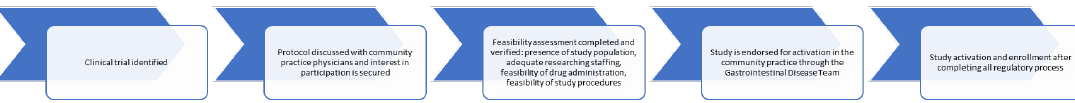
Figure 1. Process for clinical trial activation in a City of Hope Community Practice.